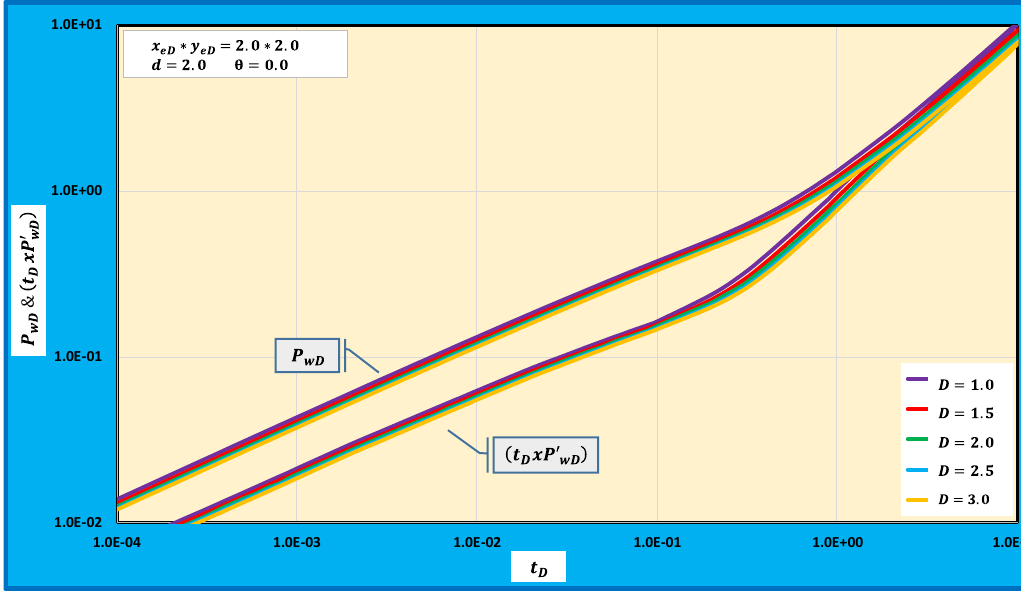
Fig. 6 Wellbore pressure and pressure derivative of different Euclidean